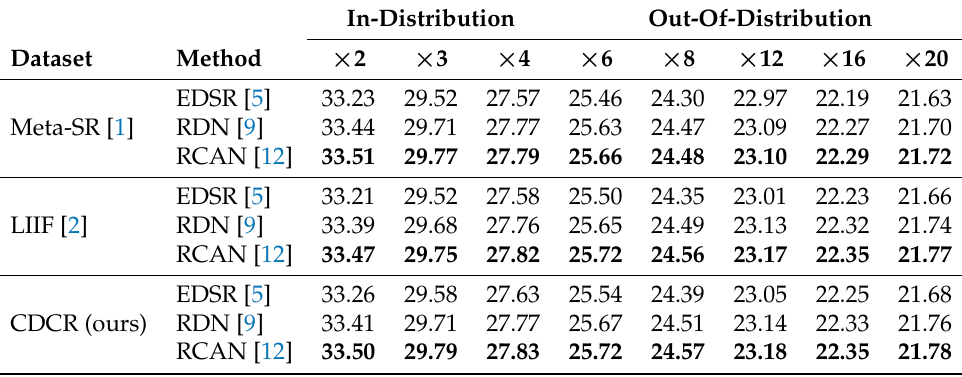
Table 4. Ablation experiment on encoder. The encoders employed in this experiment are sourced from three SISR frameworks: EDSR, RDN, and RCAN. The optimal PSNR values for each scale factor are shown in bold